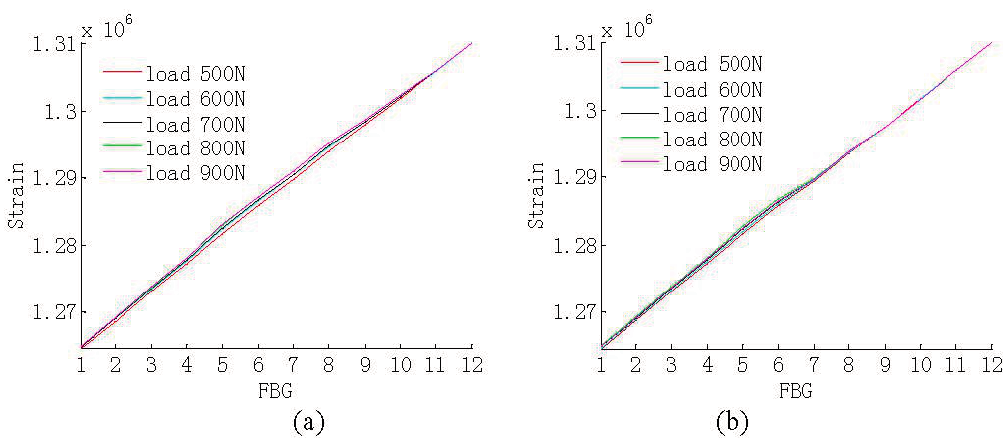
Figure 3. The strain distribution of the damaged wind turbine blade. ( a ) The single damage; and ( b ) two damaged